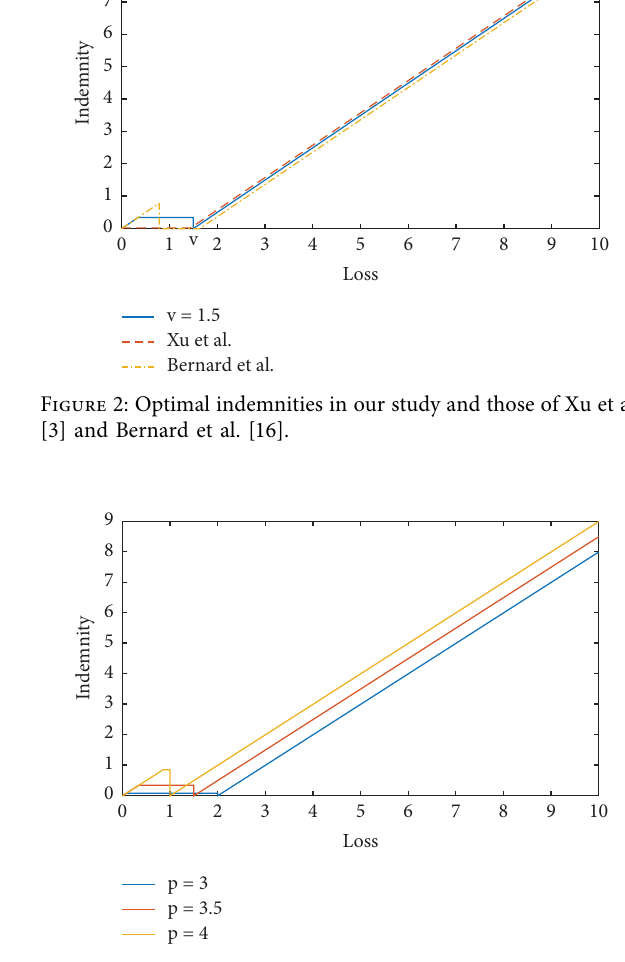
Figure 3: Optimal indemnity functions with diferent values of premium